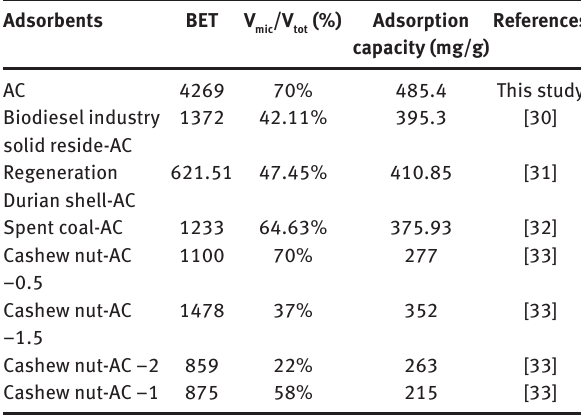
Table 3: Adsorption isotherm parameters at different temperatures. Isotherms